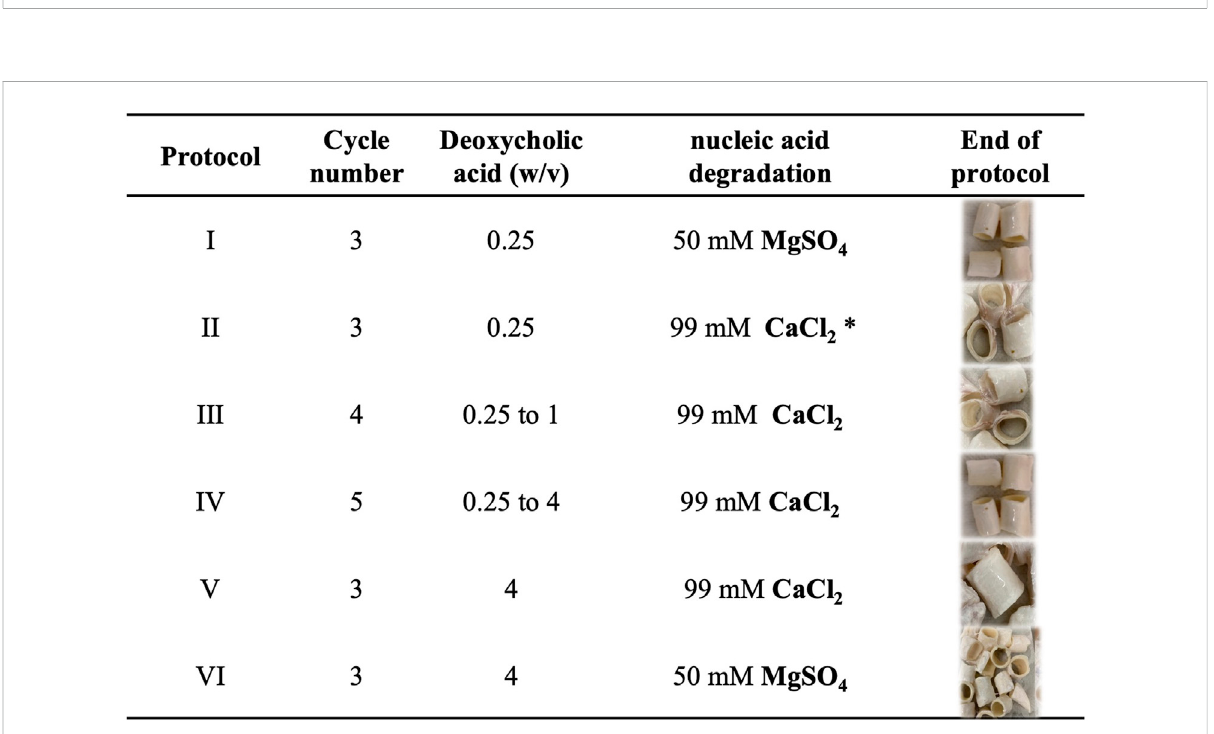
FIGURE 2 Optimizationofthedecellularizationprotocol.Inparticular(column2)thenumberofcyclesperformedandthepercentageofdeoxycholicacid dissolved in dH 2 O for each protocol tested, (column 3) the degradation step of nucleic acids made with 22.5 mg/l DNAse. Protocol I and VI provide